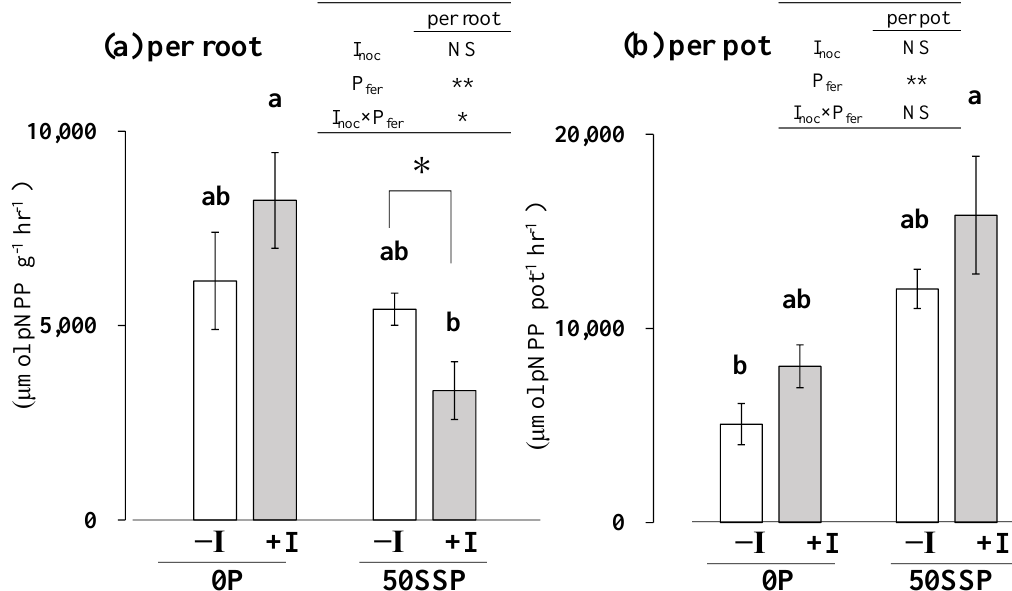
Figure 4. Acid phosphatase activity ( a ) per root and ( b ) per pot. − I/+I and 0P/50SSP indicate Rhizobium inoculation and P fertilization. Bars indicate the standard error ( n = 5). Lowercase letters indicate the significant difference between the treatments, according to Tukey’s posthoc test ( p < 0.05). * represents significant differences between the − I and +I treatments under 0P and 50SSP treatments according to Student’s t -test ( p < 0.05). NS, *, and ** in inserted tables indicate not significant, p < 0.05, and p < 0.01, respectively, estimated using two-way ANOVA; I noc and P fer indicate the effect of Rhizobium inoculation and P fertilizer, respectively.